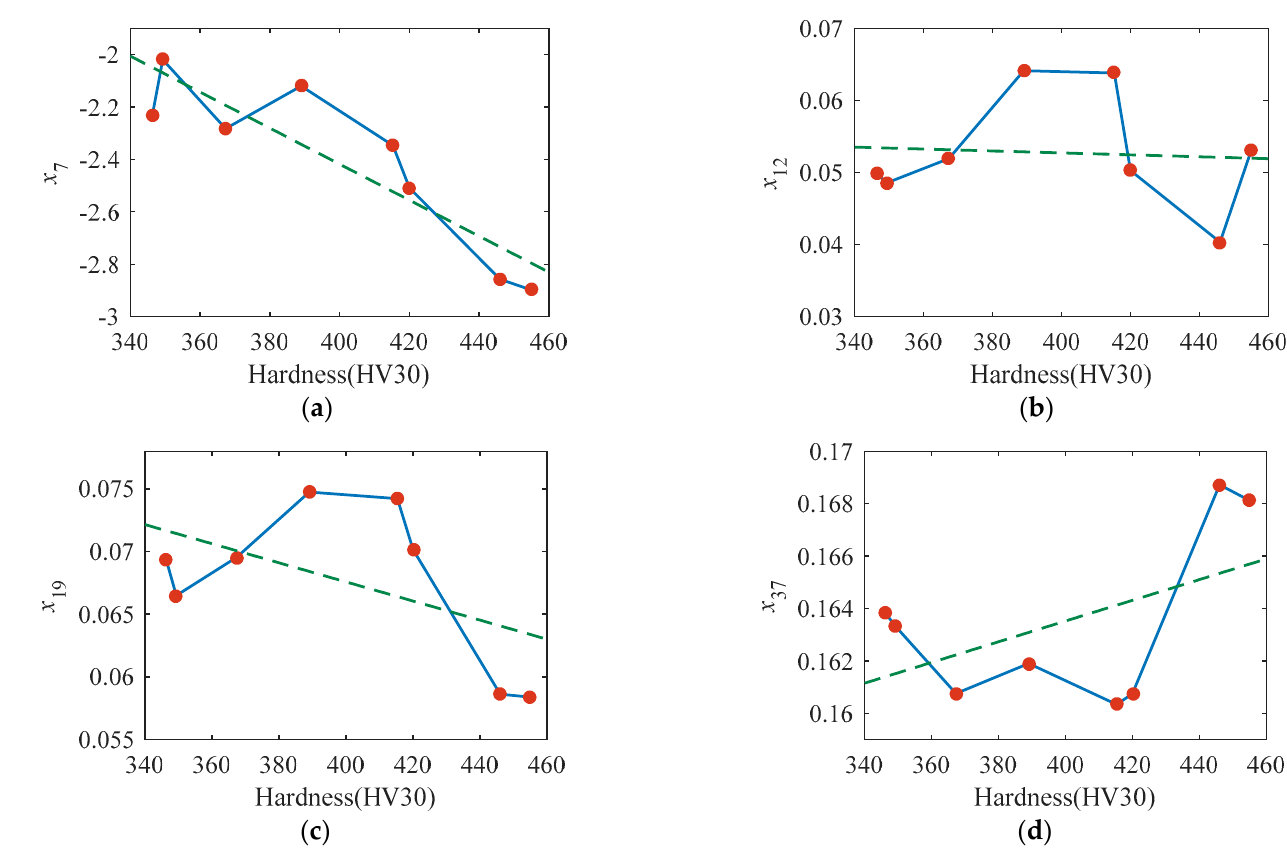
i < 0.2 was selected as a threshold for the selection of magnetic features. Therefore, only